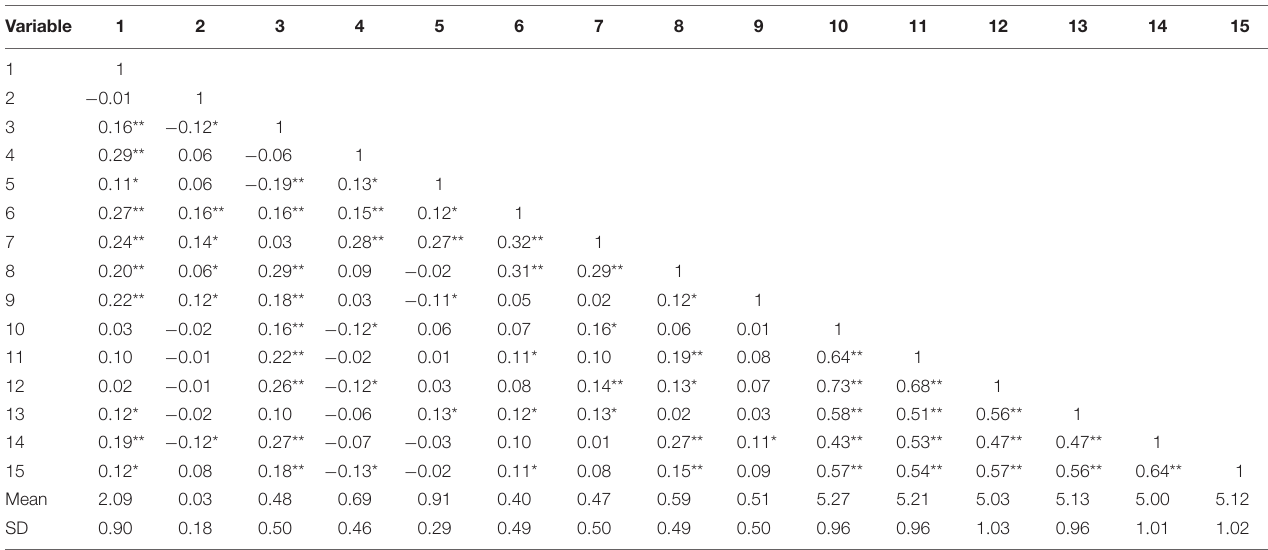
TABLE 4 | Descriptive statistics and correlation test of variables.